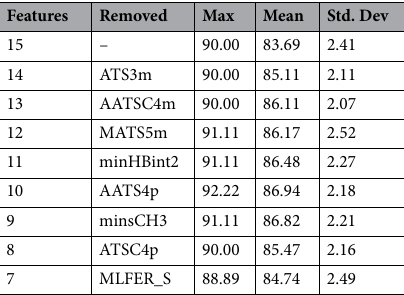
Table 7. Period lengthening dataset, maximum, mean, and standard deviation of 10-Fold CV accuracies with 100 repetitions. XGBC applied to reduced feature sets obtained by removal of a single feature at a time.